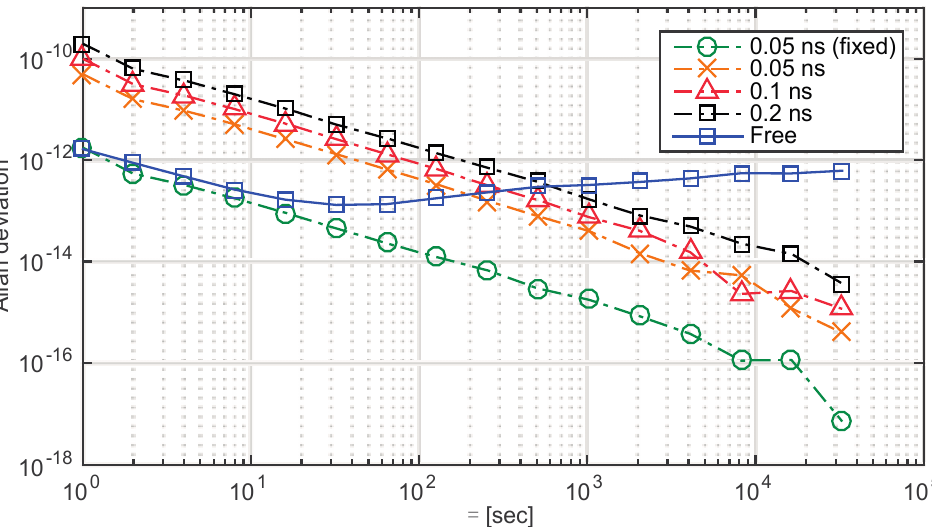
Figure 11. Comparison of the Allan deviations of a free run slave clock and a controlled clock for different residual errors. Data from the 1st hour to the 24th h are truncated to evaluate the synchronization performance. The standard deviations of the stable loops and the free run clock are 0.004 nanosecond, 012 nanosecond, 0.24 nanosecond, 0.47 nanosecond and 10 nanosecond,